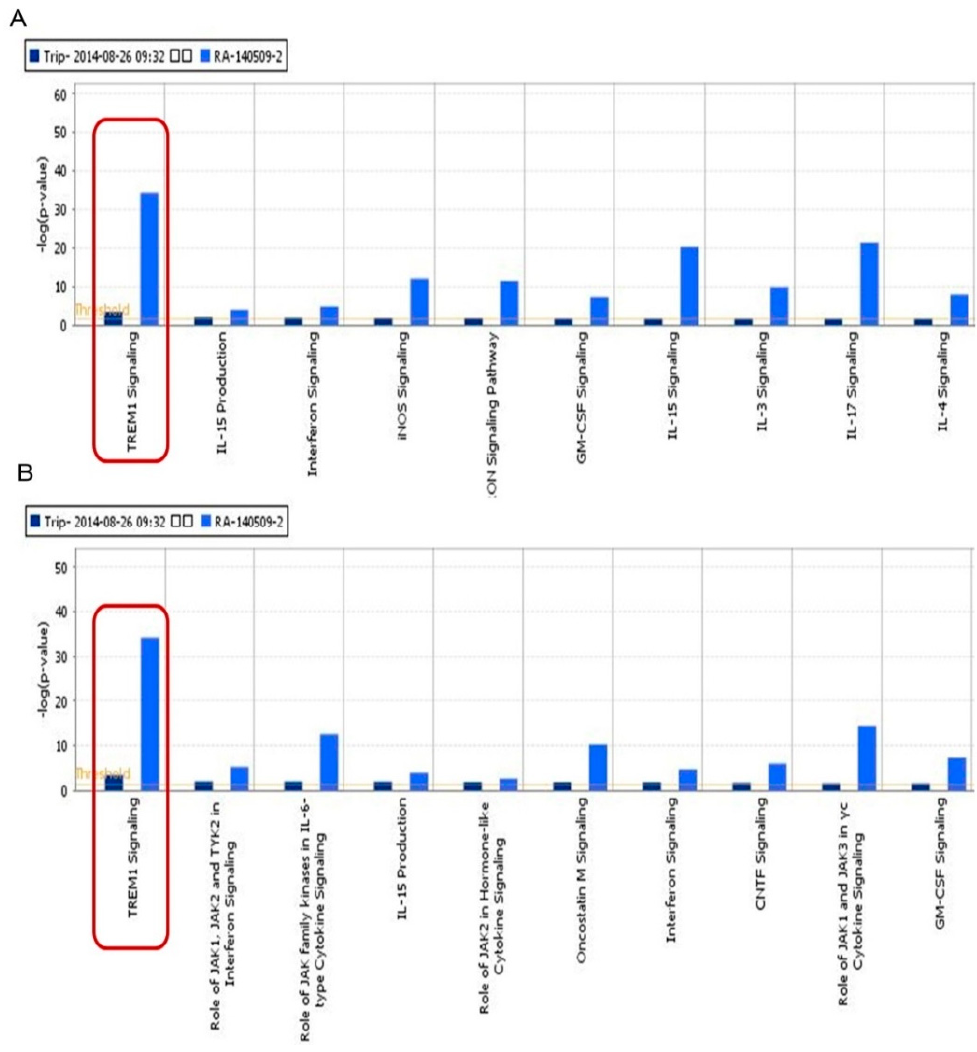
Figure 1. The results of bioinformatics analysis. Shared signaling pathways between gene molecular networks related with rheumatoid arthritis (RA) and protein targets molecular network of Triptolide (TP) in cytokine and cellular immune signaling performed using the Ingenuity Pathway Analysis (IPA) compare module. The signaling pathways of TP were represented as dark blue, while signaling pathways of RA were represented as light blue. ( A ) Cellular immune signaling; and ( B ) Cytokine signaling. The red boxes showed that TREM-1 signal pathway was the top one shared signaling pathway and participated in cytokine and cellular immune signaling. TREM-1: triggering receptors expressed on myeloid cells-1; IL: interleukin; iNOS: inducible nitric oxide synthase; GM-CSF: granulocyte-macrophage colony-stimulating factor; JAK: janus kinase; TYK: tyrosine kinase; CNTF: ciliary neurotrophic factor.